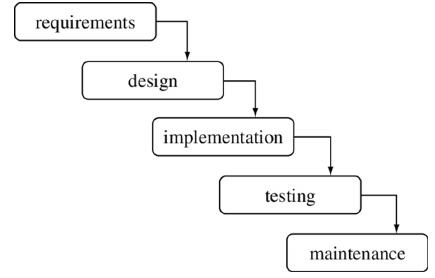
Fig. 1. Illustration of the waterfall